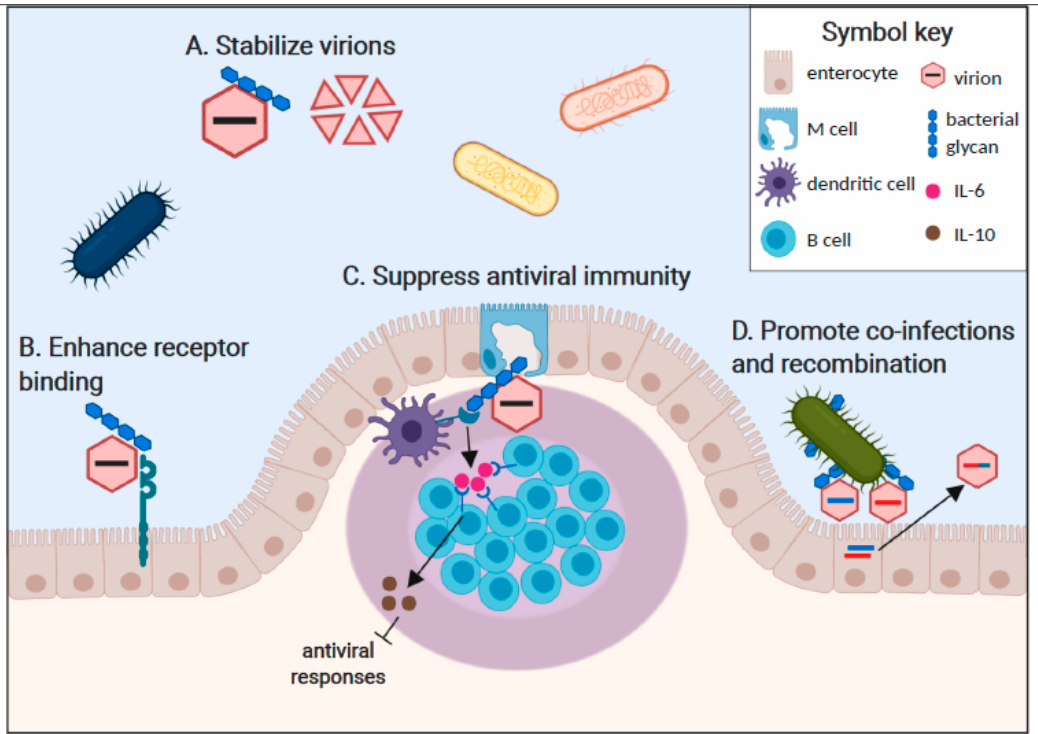
Figure 1. Commensal bacteria enhance enteric virus infections in multiple ways. A. Virion binding to bacterial glycans increases particle stability in the face of environmental stresses and thereby enhances host-to-host transmission efficiency. Poliovirus, reovirus, and norovirus particles are stabilized by bacterial ligands. B. Direct interactions of glycan-bound viral particles with cellular entry receptors enhance the stability of capsid-receptor interactions and promote initiation of infection. A specific interaction between poliovirus, its receptor (PVR), and bacterial LPS has been reported. C. Immune sensing of commensal bacterial components results in a tolerogenic gastrointestinal microenvironment that promotes enteric virus replication. For example, dendritic cell and macrophage sensing of LPS-bound MMTV through TLR4 results in the release of IL-6, which stimulates B cells to express the anti-inflammatory cytokine IL-10. D. Multi-virion clustering on bacterial surfaces increases the frequency of viral co-infection of a single cell, driving recombination potential that can result in enhanced fitness of progeny recombinant virus strains.